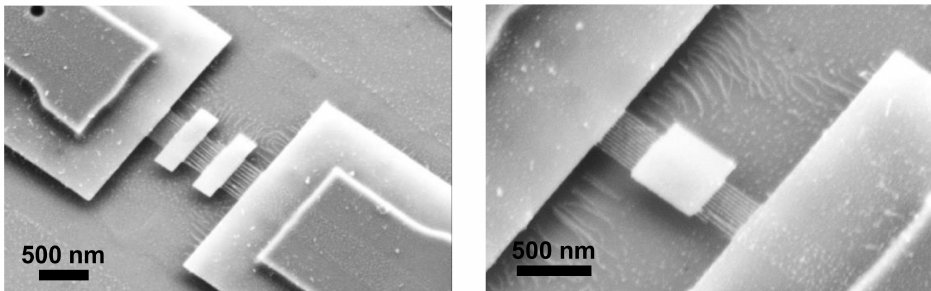
Figure 8. SEM micrographs of two of the multiple di ff erent silicon membranes obtained, suspended by high-density arrays of